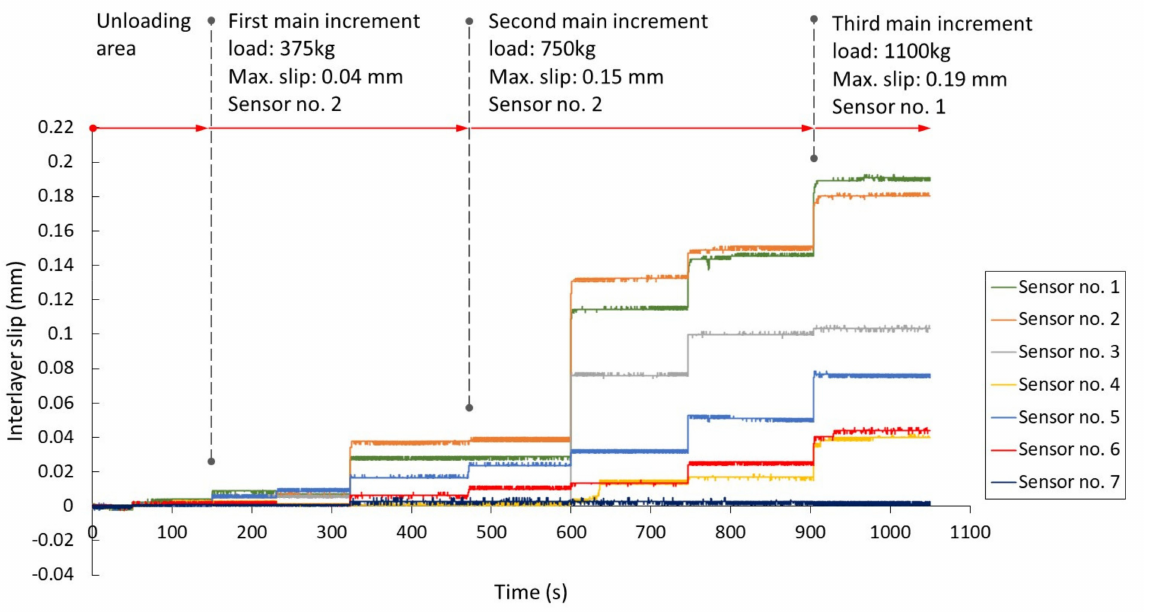
Figure 11. The interlayer slip of composite beam for single damage (second row of bolts from the right-hand side is